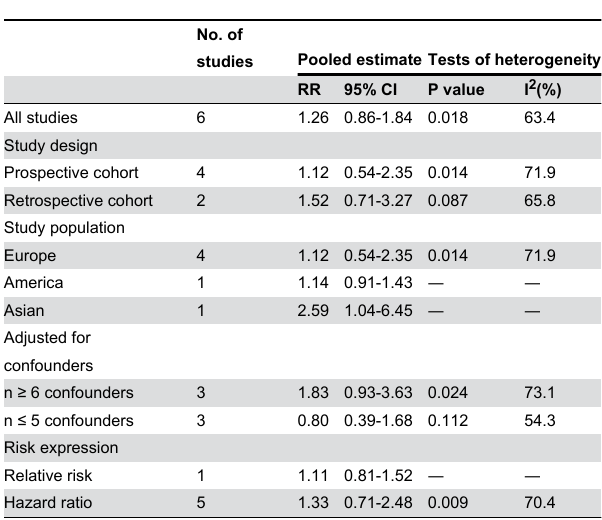
Table 3. Insulin glargine vs. non-glargine and risk of prostate